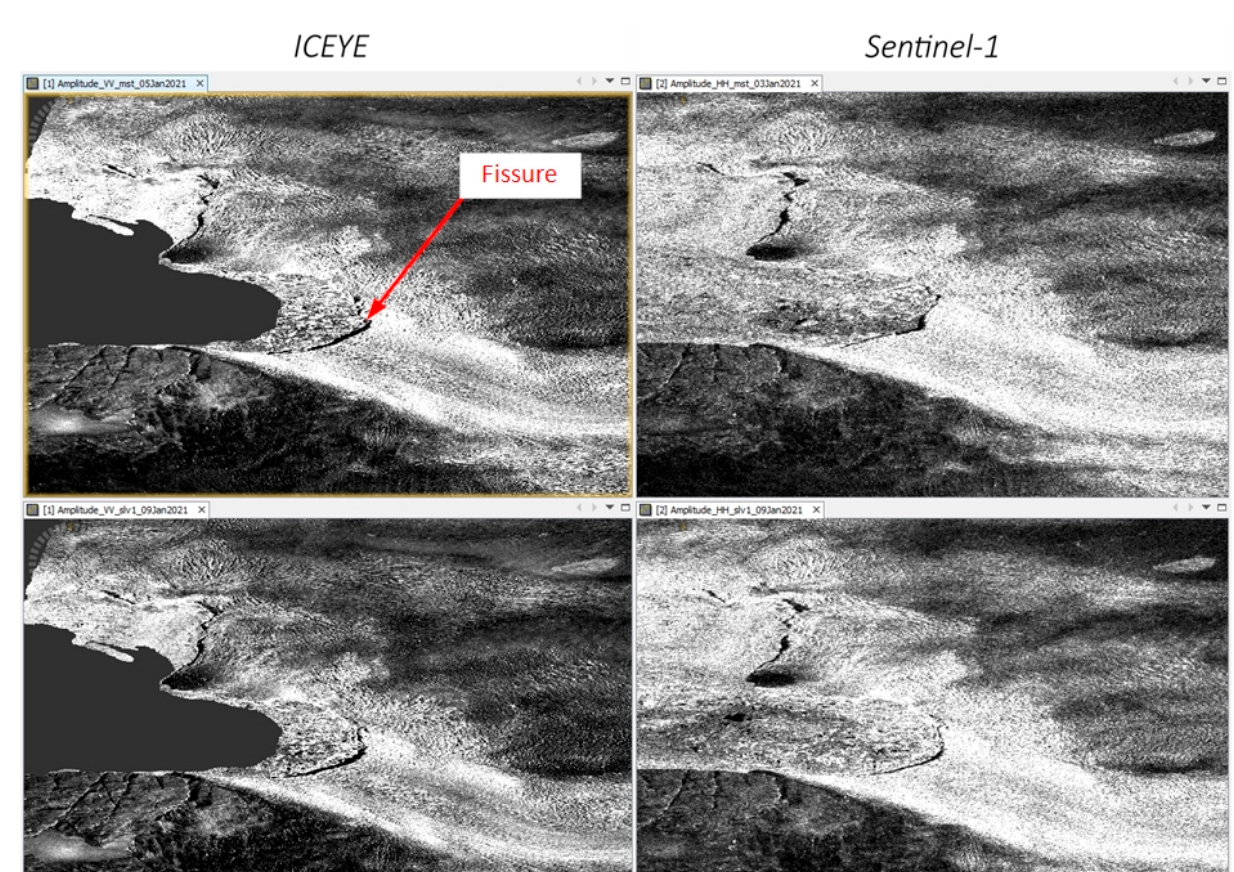
Figure 7. Amplitude images from radar data acquired on 5 and 9 January 2021 by the ICEYE satellite and 3 and 9 January 2021 by the Sentinel-1 satellite.